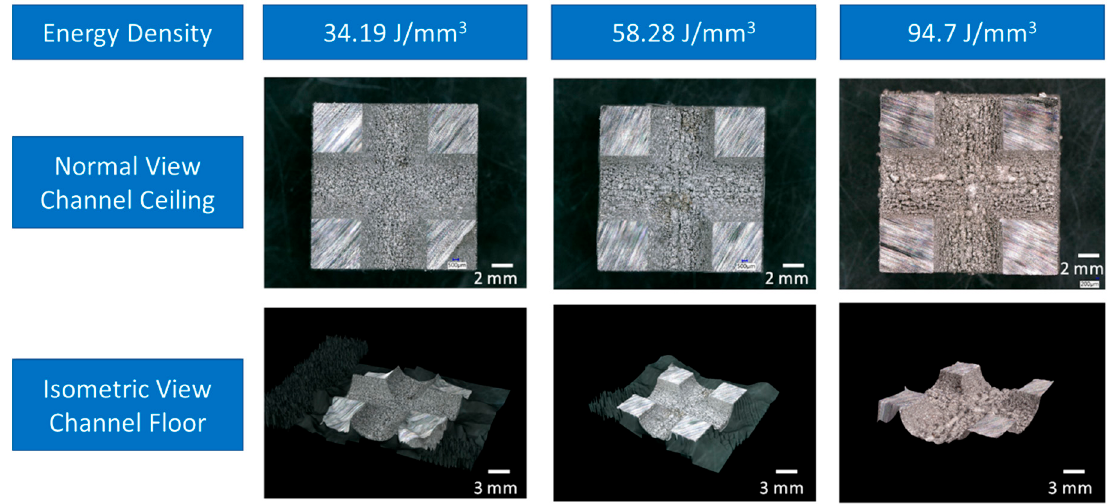
Figure 8. Cross-sectional views of the channel ceiling of the selected samples.